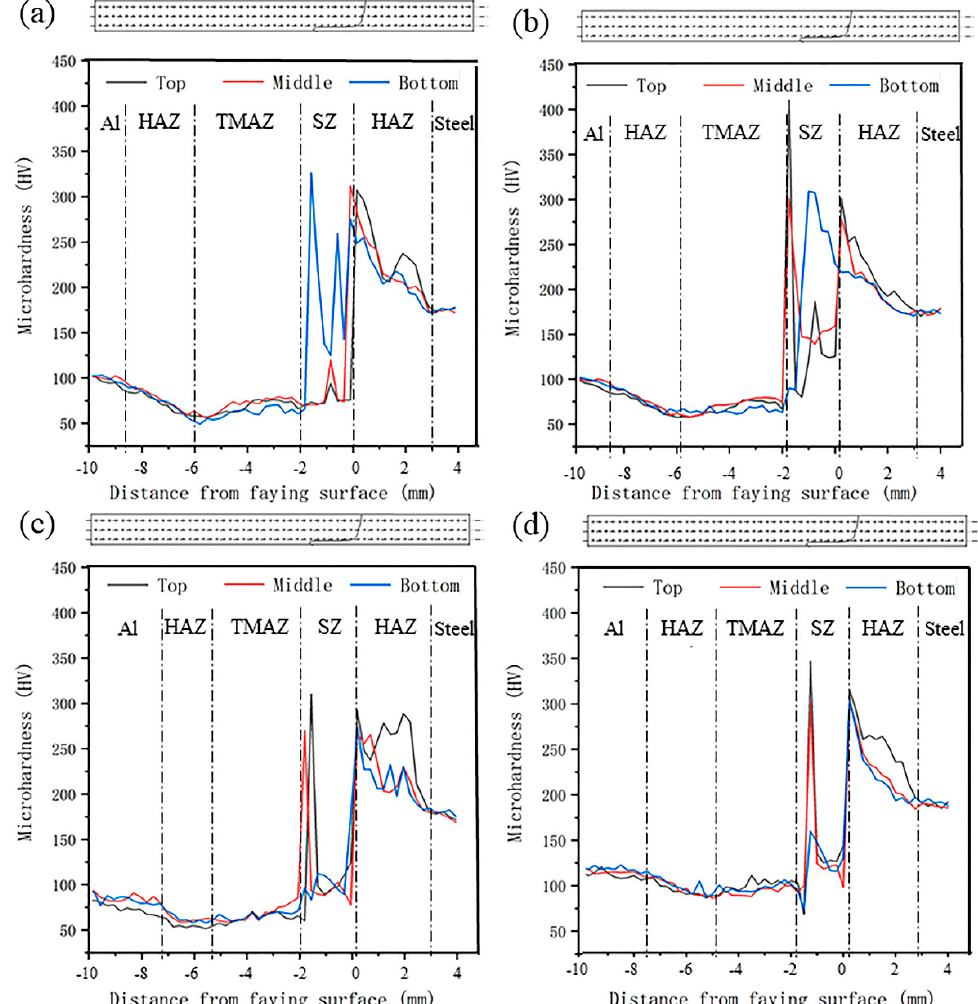
Figure 13. This figure corresponds to the microhardness values of the connector of ( a ) serial number 1, ( b ) serial number 2, ( c ) serial number 3, ( d ) and serial number 4 in the parameters of Table 2.